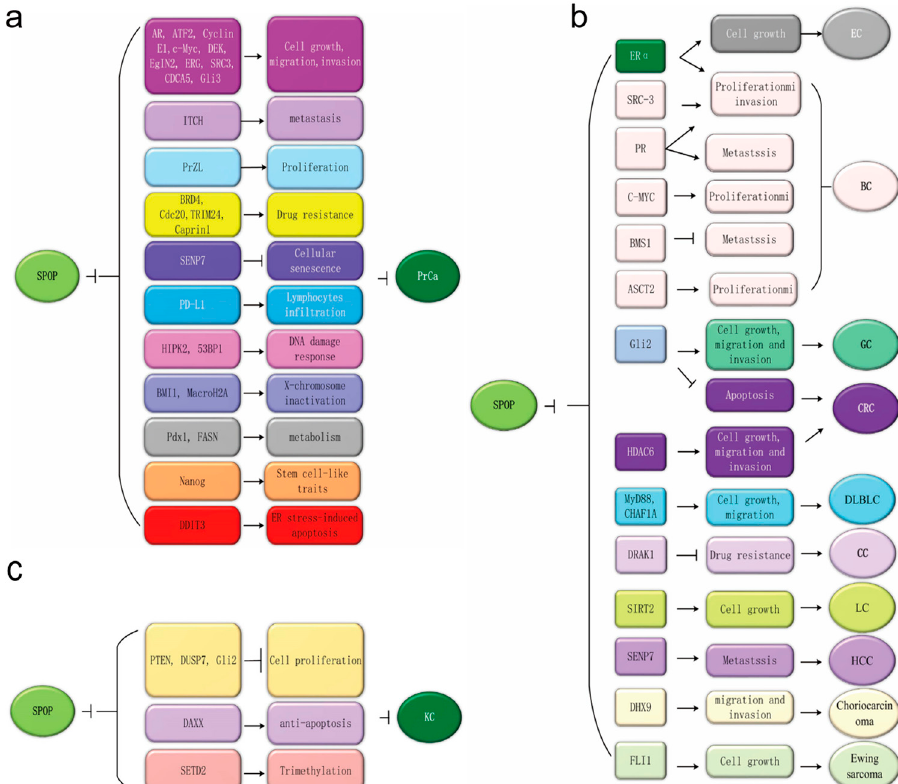
Figure 3. The potential oncogenic functions of Speckle-type POZ (pox virus and zinc finger protein) protein (SPOP) in kidney cancer and tumor-suppressive roles in other cancer types. ( a ) SPOP exerts potential antitumor activity by regulating proliferation, migration, invasion, metastasis, apoptosis, drug resistance, cell senescence and lymphocyte infiltration via modulating various substrates in PrCa. ( b ) SPOP has tumor-suppressive effects across multiple cancer types, including endometrial, gastric, colorectal, cervical and lung cancers, hepatocellular carcinoma, choriocarcinoma, Ewing sarcoma and diffuse large B-cell lymphoma. It has dual roles in breast cancer that regulate the degradation of its various substrates. ( c ) SPOP exerts its potential oncogenic activity by enhancing the ubiquitination and degradation of Phosphatase and tensin homolog (PTEN), Dual-Specificity Phosphatase 7 (DUSP7), Gli2 and SETD2 to promote renal carcinogenesis.